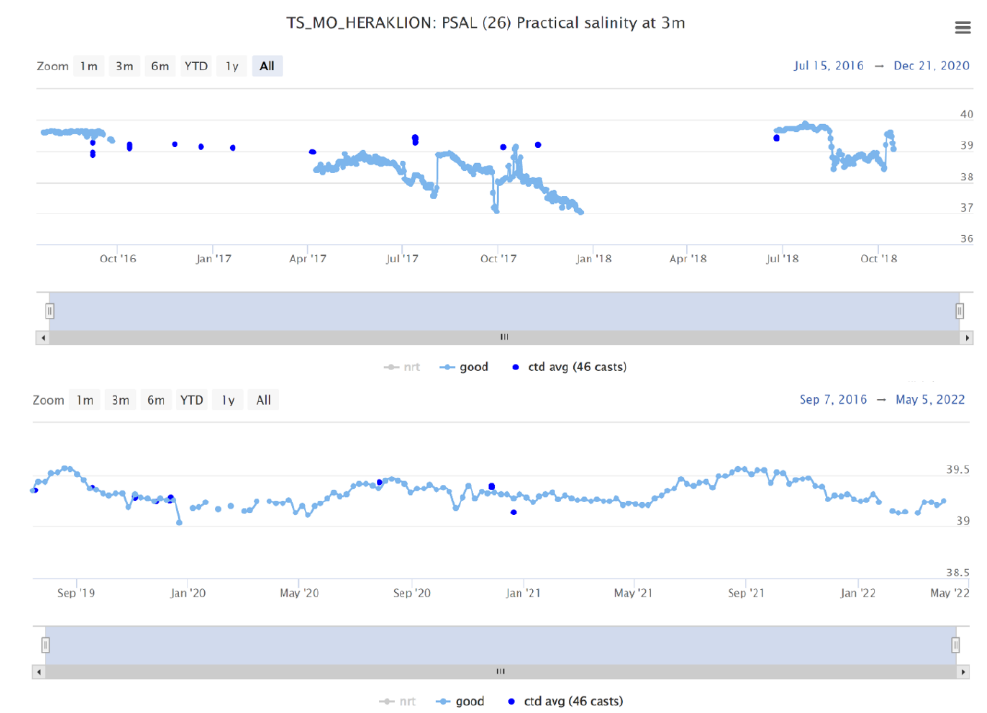
Figure 11. The improvement of the salinity measurements after the replacement of the exposed surface sensor with one equipped with a pump and a flow-through system proven to be more effective against fouling.